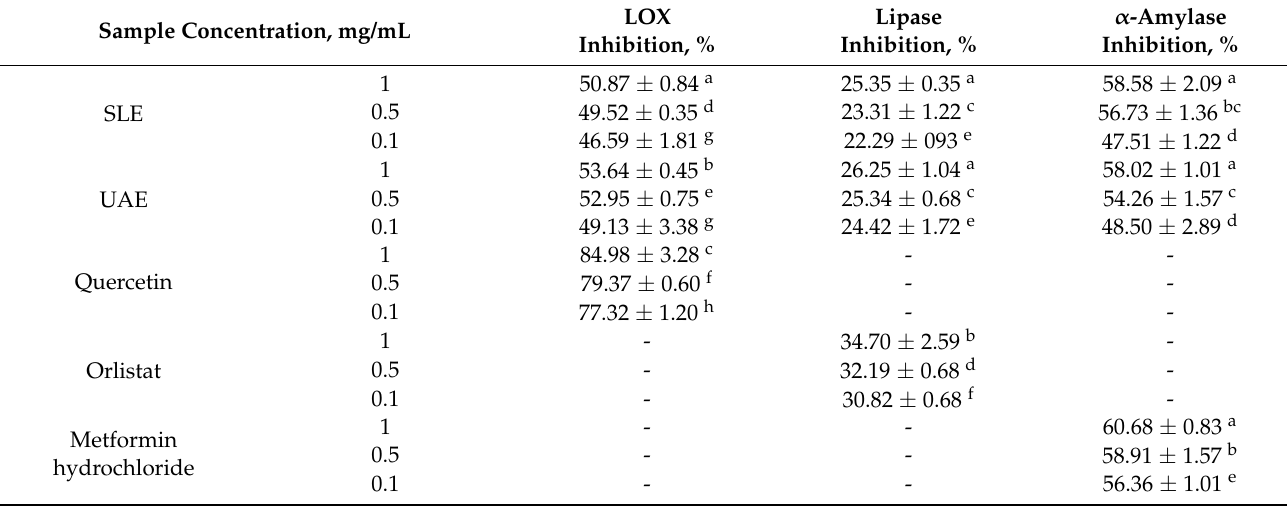
Table 2. The enzyme inhibition percentage of SLE and UAE selected extracts and positive controls in LOX, lipase, and α -amylase enzymes at different concentrations.